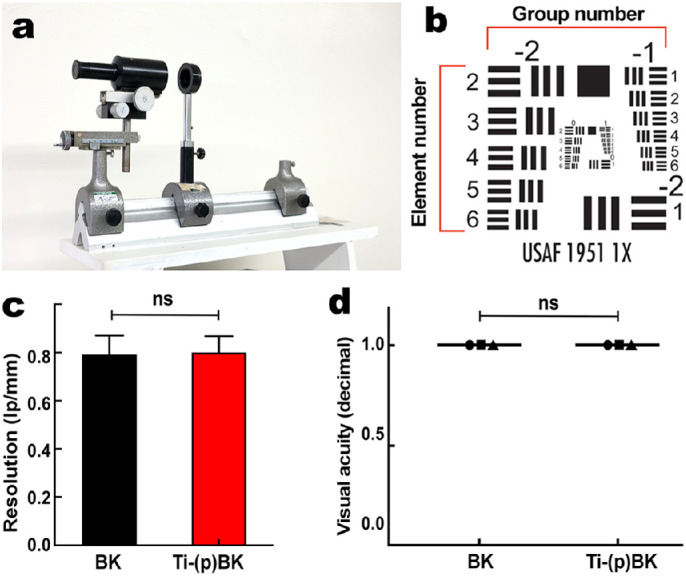
Transparency-resolution analysis using an optical bench composed of a microscope, a diaphragm to hold the BK (a) and a resolution chart (b) placed 304.8 cm away from the diaphragm. (c) The resolution calculation revealed no significant differences between BKs before and after processing (P > 0.05). (d) Three independent observers found equal sharpness through BKs before and after processing; P > 0.05.